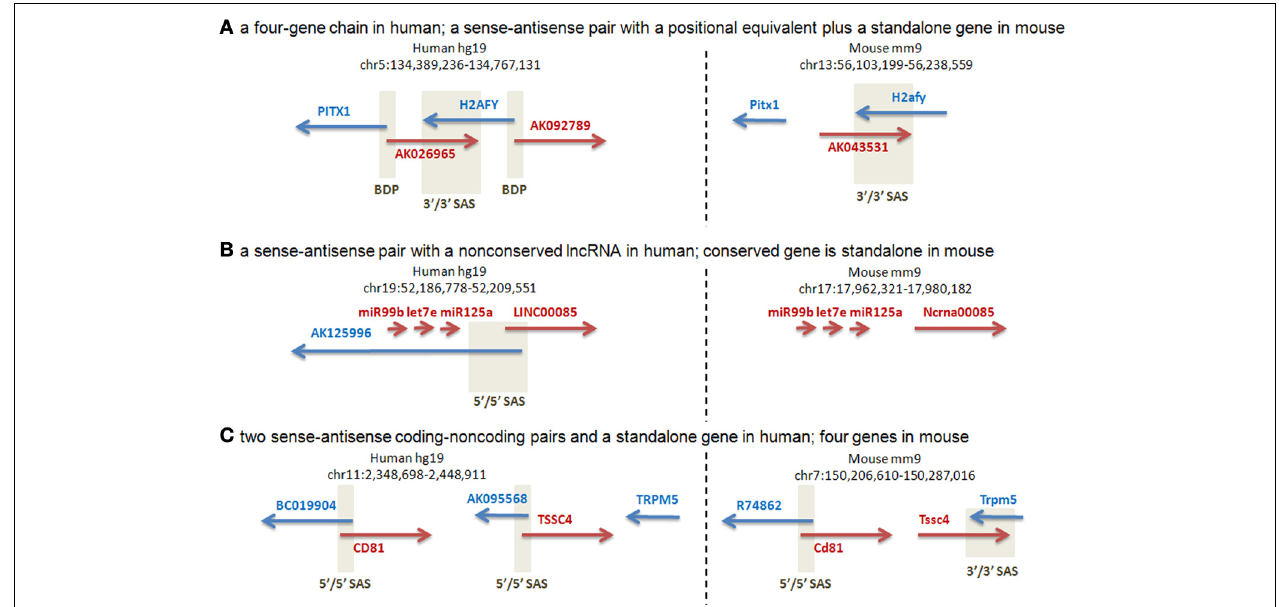
FIGURE 4 | Manual annotation of selected orthologous loci with human-mouse gene structure distinctions. Positive-strand transcription, relative to the genome assembly, is in red. Negative-strand transcription, relative to the genome assembly, is in blue. Beige boxes delineate bidirectional promoters (BDP) and sense-antisense overlaps (SAS). A 5 (cid:2) /5 (cid:2) SAS is an overlap of two genes at their 5 (cid:2) ends (a divergent overlap). A 3 (cid:2) /3 (cid:2) SAS is an overlap of two genes at their 3 (cid:2) ends (a convergent overlap). (A) Two protein-coding genes have orthologs: PITX and H2AFY. H2AFY has a positionally equivalent [see Babak et al. (2007) for definition] SAS lncRNA at its 3 (cid:2) end (AK026965 in human) in both species, suggesting a sequence-independent requirement for SAS pairing of H2AFY. In human, H2AFY shares a bidirectional promoter with another lncRNA (AK092789) for which no genomic or transcriptional conservation exists in mouse. (Supplementary Dataset 5: rows 62–63.). (B) The human protein-coding gene